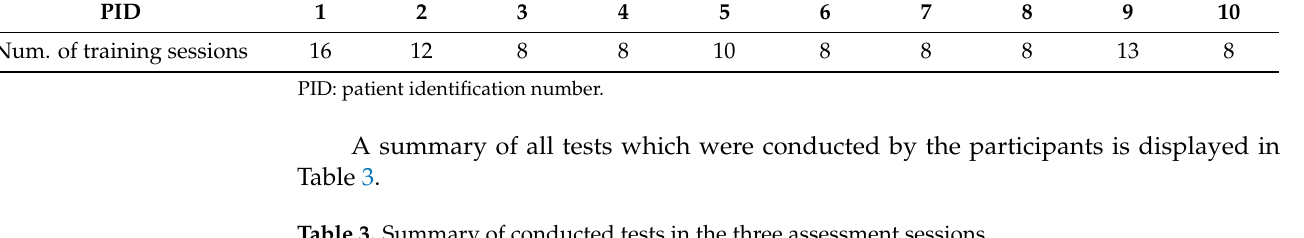
Table 3. Summary of conducted tests in the three assessment